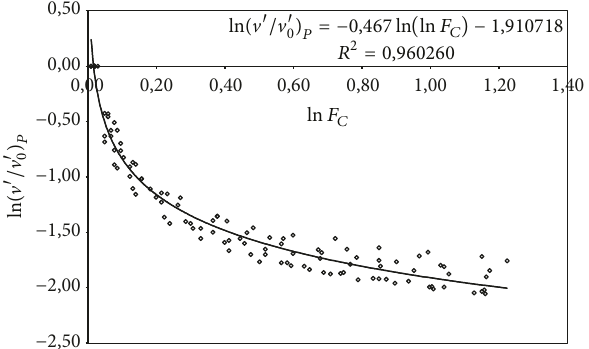
Figure 4: Relative permeate flux as a normalized function of concentration factor at transmembrane pressures between 20 and 40 bar and feed flow rates between 1 and 12 Lmin −1